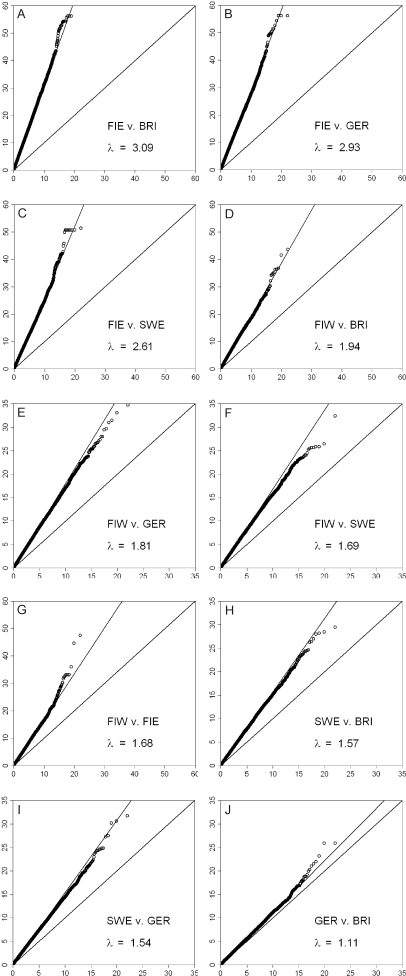
Quantile-quantile plots of allele frequencies between population pairs.λ denotes the overdispersion factor. One SNP with an observed value of ∼120 has been left out from all the plots with the Germans. Note the two different scales of the axes. Abbreviations as in Figure 1.